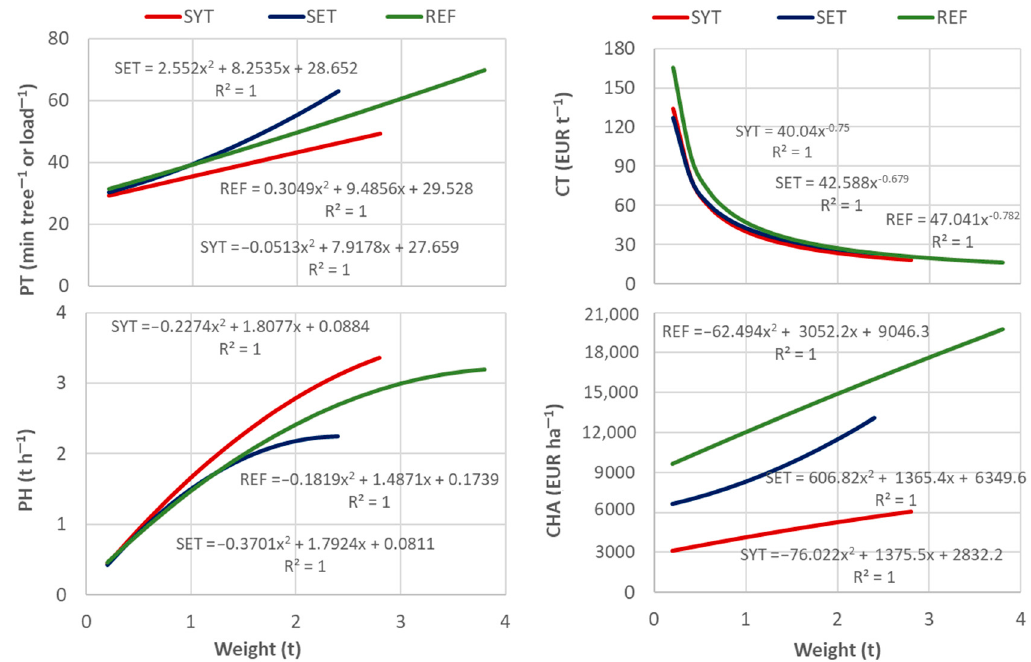
Figure 2. Curves of general models and relative equations of the total forest logging for SYT (systematic thinning), SET (selective thinning), and REF (regeneration felling), as a function of weight (PT, productive working time, min per tree or load; PH, productivity, tons per hour; CT, cost, EUR per ton; CHA, cost, EUR per hectare).